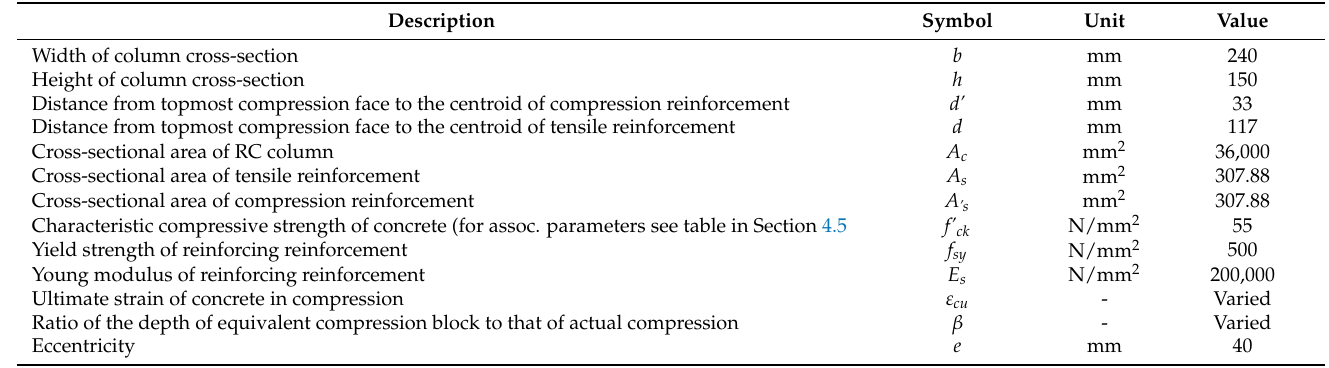
Table 1. List of parameters used in the